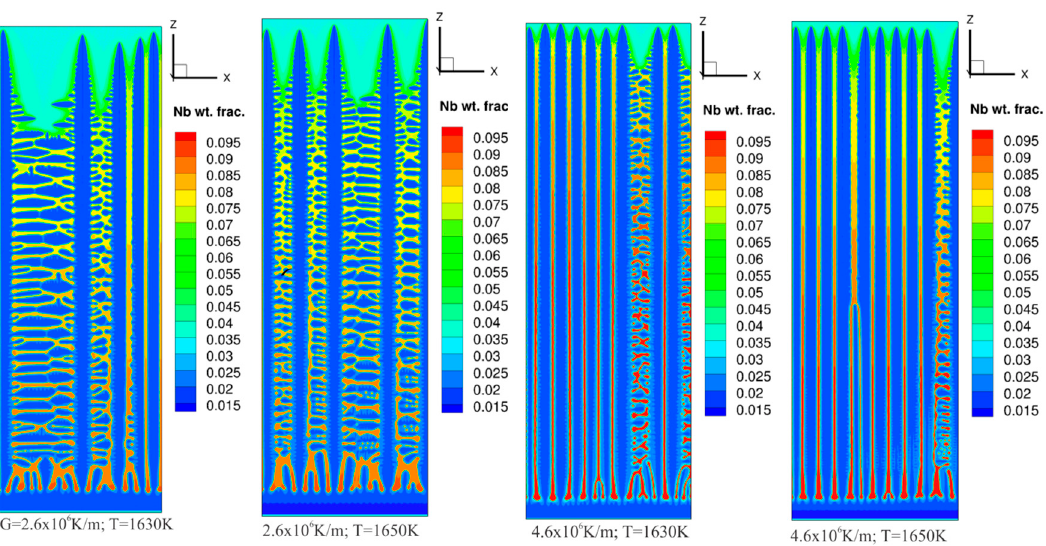
19 of 28 Figure 13. Effect of initial undercooling at the s-l interface and the temperature gradient in the liquid on the solidification morphology. D = 1 × 10 − 9 m 2 /s and sd = 500.